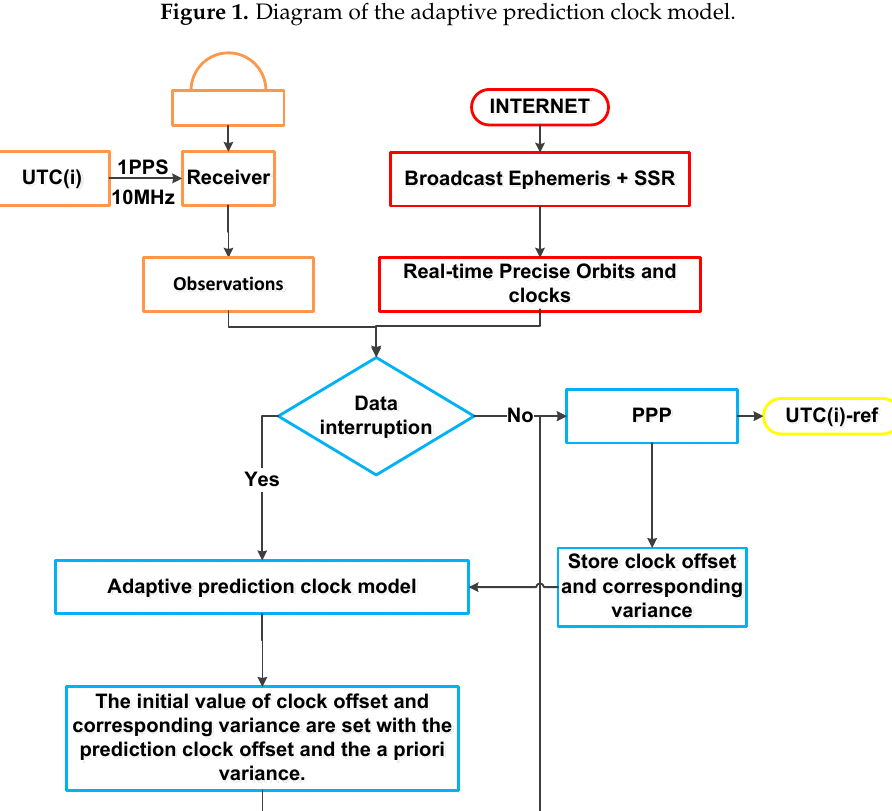
Figure 2. Diagram of the RT-PPP (real-time PPP) time and frequency transfer using the clock model.